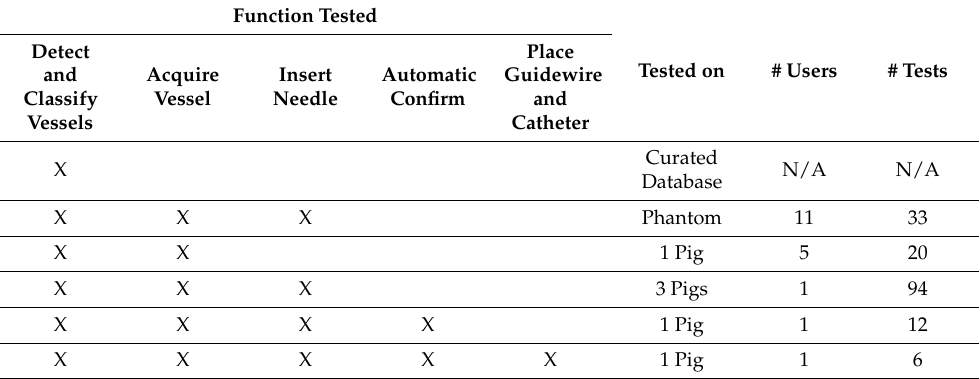
Table 3. AI-GUIDE test